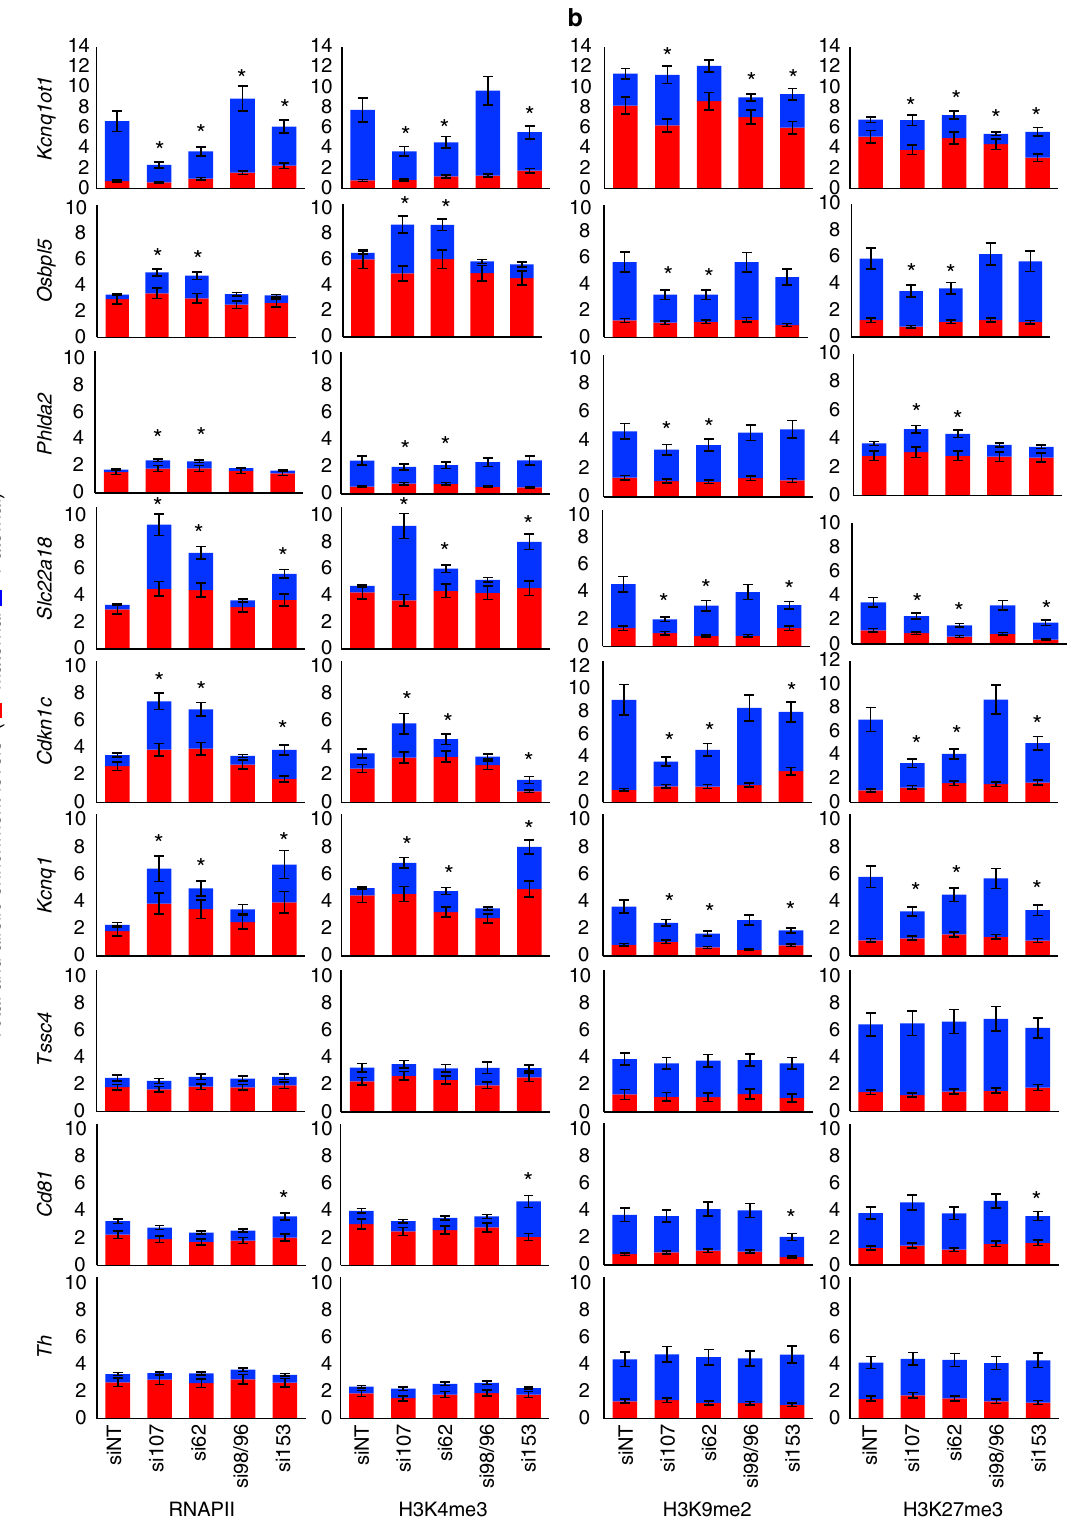
Fig. 5 Nup107, Nup62 , and Nup153 depletion disrupts RNAPII enrichment and histone modi fi cations at the Kcnq1ot1 ICR and imprinted gene promoters. a RNAPII and H3K4me3 ChIP at the maternal and paternal Kcnq1ot1 ICR and imprinted gene promoters in control and Nup -depleted XEN cells ( n = 3; n = 3 technical replicates). b H3K9me2 and H3K27me3 ChIP at the maternal and paternal Kcnq1ot1 ICR and imprinted gene promoters in control and Nup - depleted XEN cells ( n = 3 biological samples with three technical replicates per sample). The y -axis indicates total and allelic ChIP enrichment levels represented as percent of input. Allelic proportions are represented as a percent of the total ChIP enrichment level. Error bars, s.e.m.; *, signi fi cance p < 0.05 of paternal/maternal levels compared to the siNT paternal/maternal control ( t